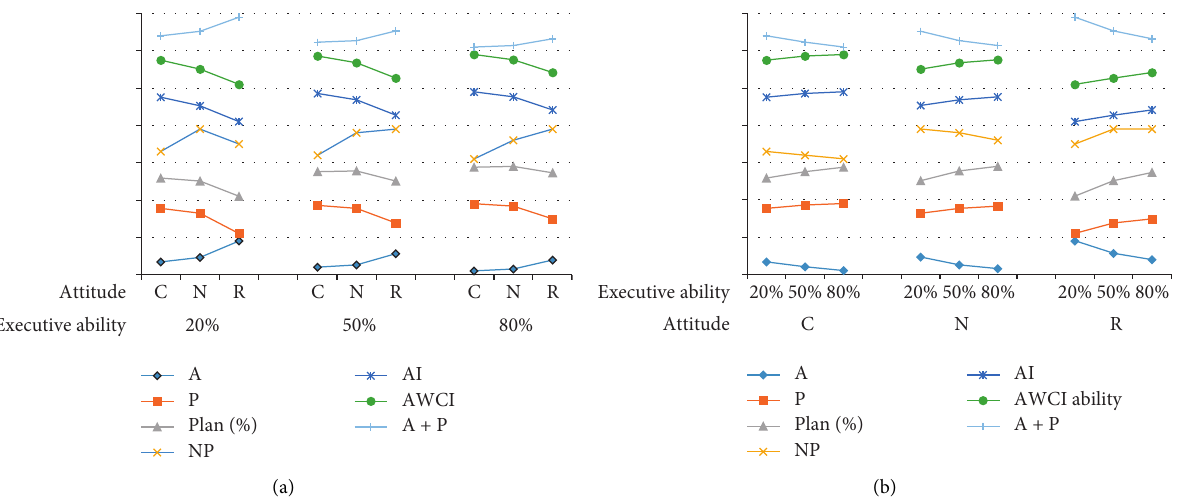
Figure 6: Index comparison under different risk preferences and executive ability of planning (in the situation of reasonable planning).